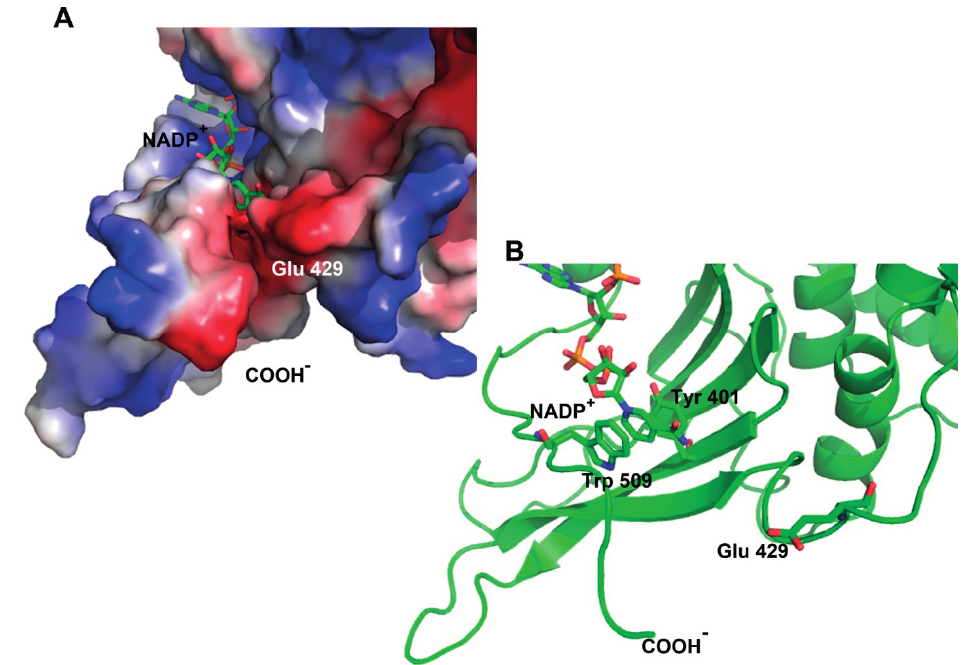
Figure 7. Schematic representation of human G6PD enzyme (PDB code 2BH9). ( A ) Surface electrostatic potential of the crystallographic structure of the G6PD; and ( B ) G6PD in ribbon format, shown are π – π interactions between the amino acid residues Try 509 and Tyr 401 with the pyramidal ring of NADP + . Modeled with PyMOL